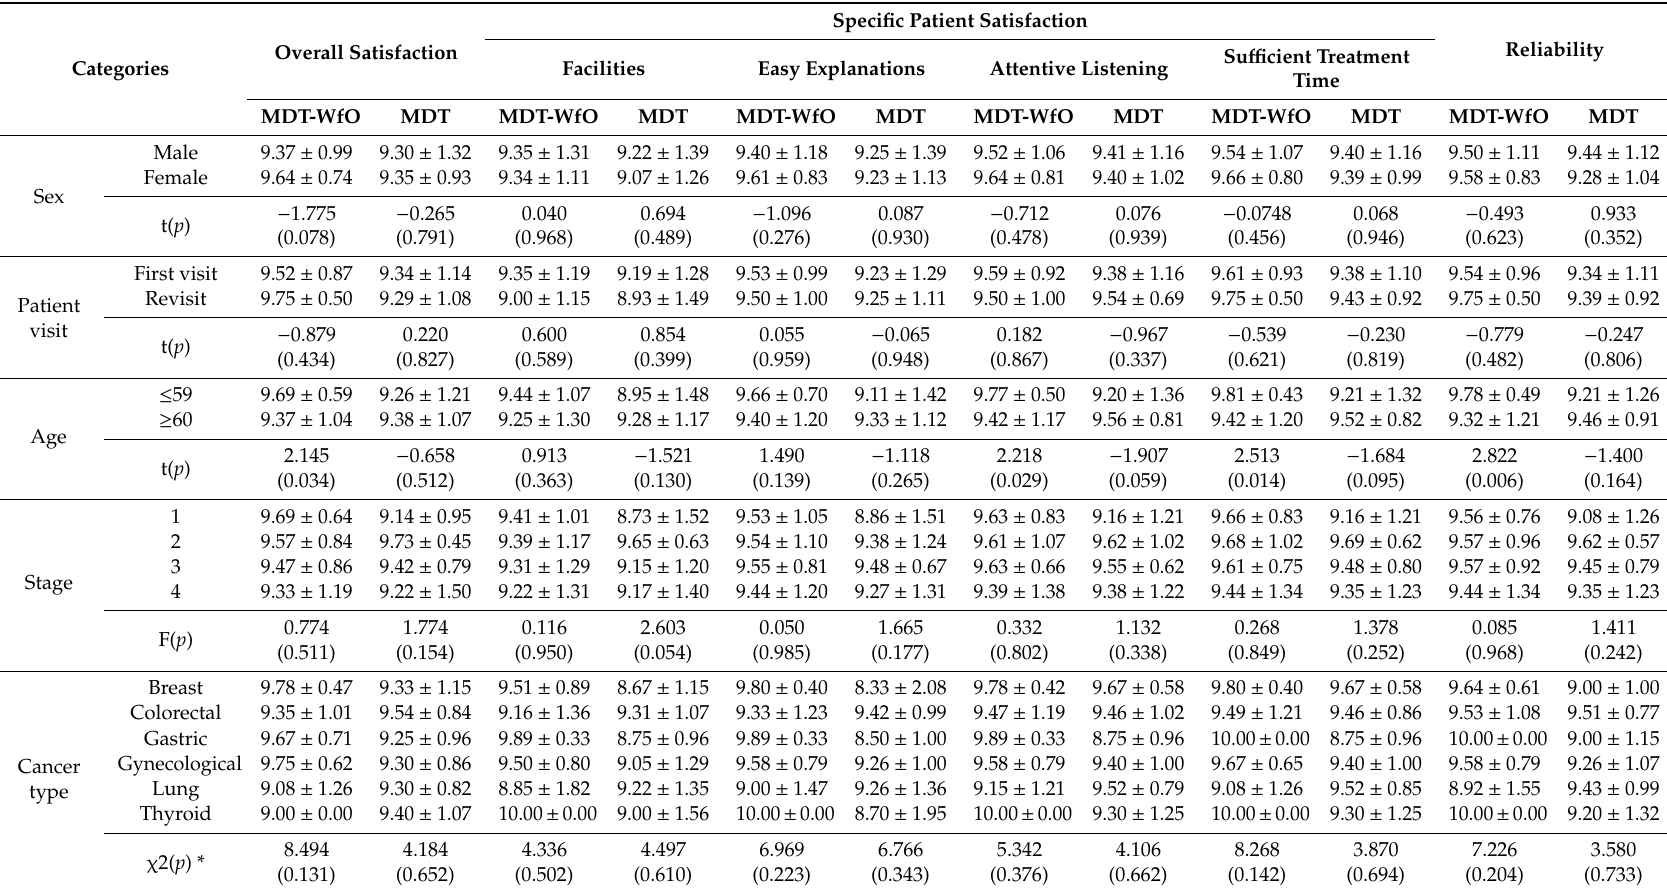
Table 4. Patient satisfaction and reliability within treatment